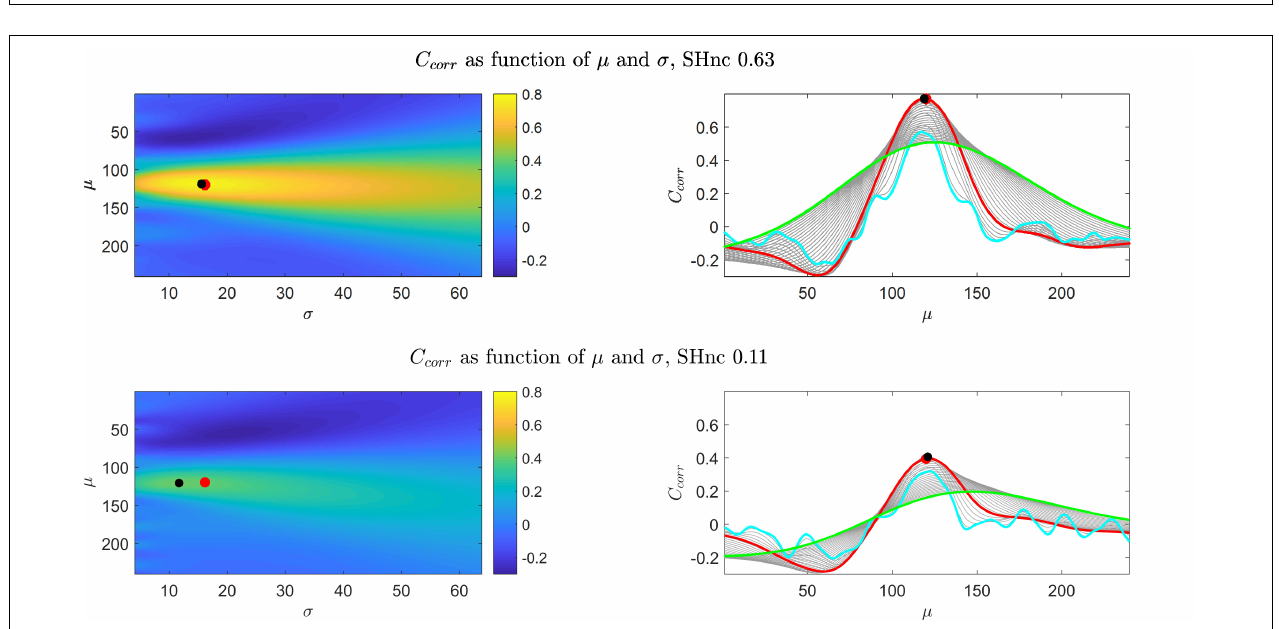
FIGURE 2 | Results obtained from the simulations of the one dimensional pRF characterizing the preference to sound frequencies (i.e., auditory fMRI data). Upper and bottom left panels show C corr as a function of µ and σ for high and low SHnc respectively. The right panels show the corresponding profiles with respect to µ , while the different (gray) curves are obtained with different σ values. The values of C corr as a function of µ for the broadest and narrowest possible pRFs are displayed in green and cyan respectively. The values of C corr as a function of µ for the pRF that generated the data are depicted in red. Red dots and black dots denote the µ , σ used to generate the data and the global minimum respectively. In the high SHnc scenario the generative pRF (red) and the global minimum (black) are in the same location in the ( µ , σ ) space (the dots are superimposed).